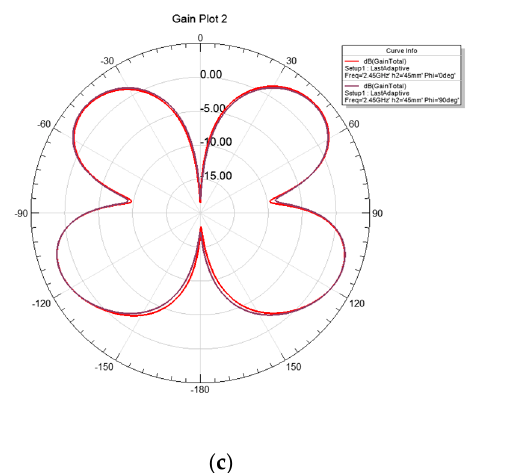
Figure 7. The nondirectional antenna information: ( a ) the antenna model; ( b ) the antenna radiation in 3D; ( c ) the antenna radiation; ( d ) the antenna prototype.